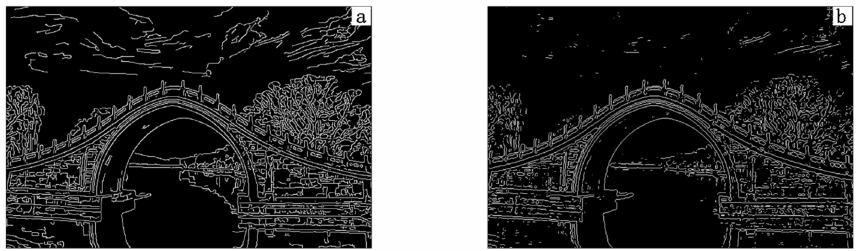
Figure 13. Detection results: ( a ) Canny’s algorithm. ( b ) Laplace’s